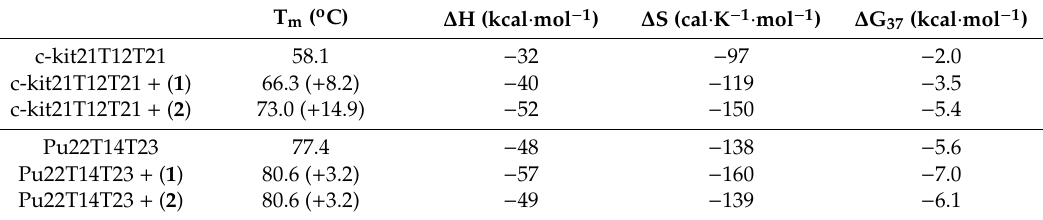
Figure 3. CD spectra recorded along the titration of c-kit21T12T21 with ( a ) BMH-21 ( 1 ) and ( b ) BA-41 ( 2 ). In both cases, the medium consisted of 20 mM phosphate bu ff er (pH 7.0) and 5 mM KCl. DNA concentration was 1 µ M. Ligand concentration ranged from 0 to 3 µ M. Experiments were carried out at 25 ◦ C. Table 1. Thermodynamic parameters for the folding calculated from the ellipticity vs. temperature traces, considering a two-state process. The uncertainty in T m values was ± 0.7 ◦ C. Uncertainties in ∆ H 0 and ∆ S 0 values were lower than ± 5%. Uncertainties in ∆ G 0 values were lower than ± 10%.